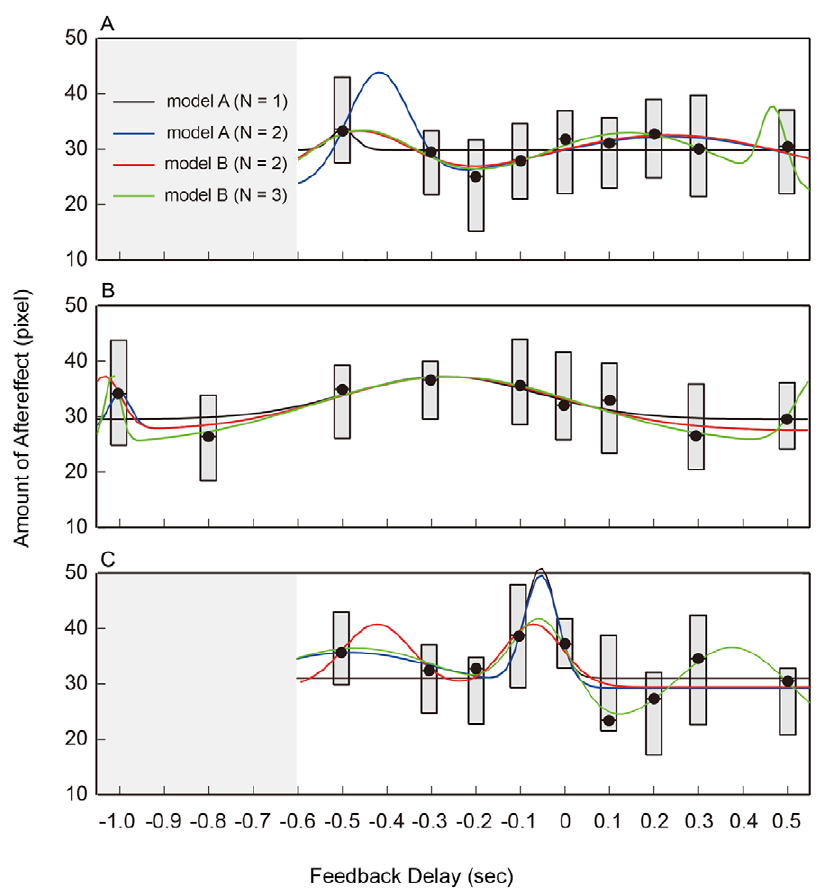
Figure 3. Experimental Results. The estimated aftereffect ( A d : see Materials and Methods) is plotted against the delay conditions. The box plot shows the quartiles: thick segments indicate the medians, and the top and bottom of the boxes show the 25th and 75th percentiles. Line plots are the curves fitted using four different radial basis functions. A: Cursor movement time (cMT) was 600 ms and no timing cue was presented (Expt. 1), B: cMT was 1100 ms and no timing cue was presented (Expt. 2). C: cMT was 600 ms and the timing cue was presented (Expt. 3). In each case, radial basis curves with two basis functions seem to best fit the experimental result, implying that the relationship between the feedback delay and aftereffect had two